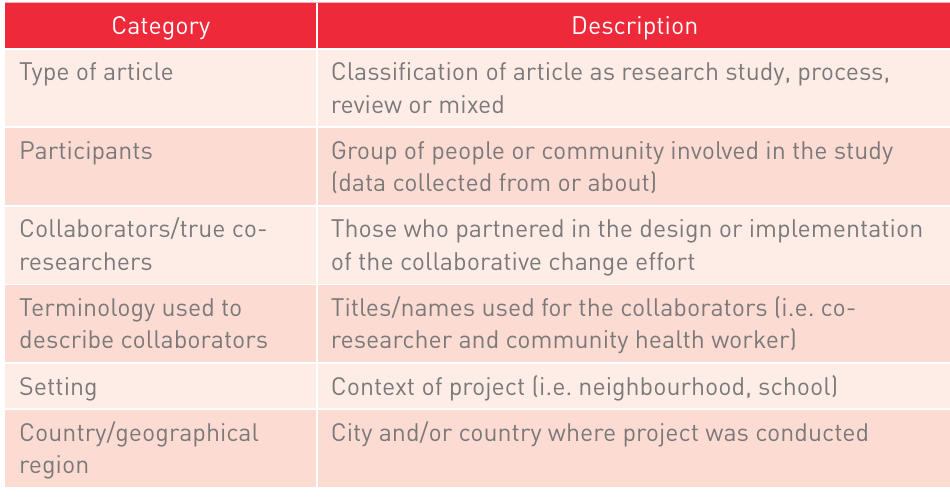
Definitions of categories and